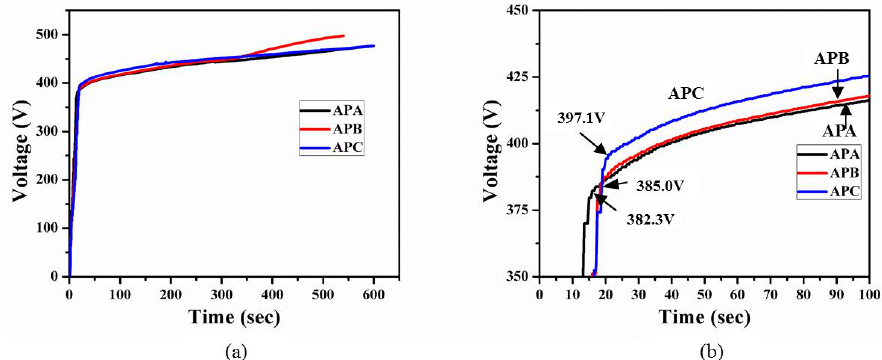
Figure 1. The voltage‐time responses of PEO processes ( a ) with different concentrations of Si 3 N 4 and borax, and ( b ) the enlarged plots from 0 to 100 s indicated with the breakdown voltage values. Metals 2020 , 10 , x FOR PEER REVIEW